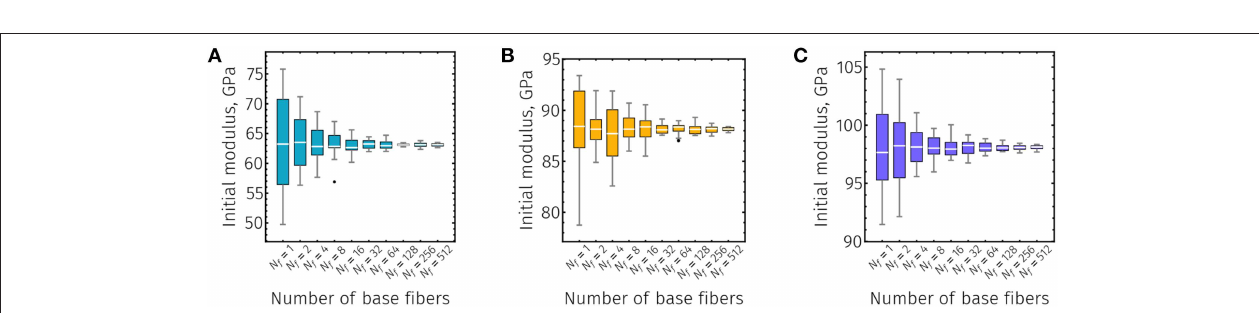
FIGURE 7 | Box-whisker plots of (A) initial moduli and (B) strengths of CNC films with 50% regular and random orderings for L = 50, 150, and 300nm. Random offset distributions are either normal (N x % ) or uniform (U x % ) with mean 50%, where x % indicates standard deviations and maxima of the normal and uniform distributions, respectively. The box-whisker plots for each ordered structure contains 20 independent simulations. White horizontal lines, colored box, gray vertical lines, and black dots indicate the median, interquantile range (IQR) between 3rd and 1st quantiles, range (of all data within ± 1.5 × IQR), and outliers (points outside the range), respectively. Numeric values of the distribution medians are listed above their respective box-whisker plots.